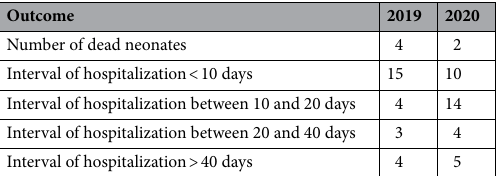
Table 3. Outcome of neonatal patients admitted to tertiary health facilities after NET.